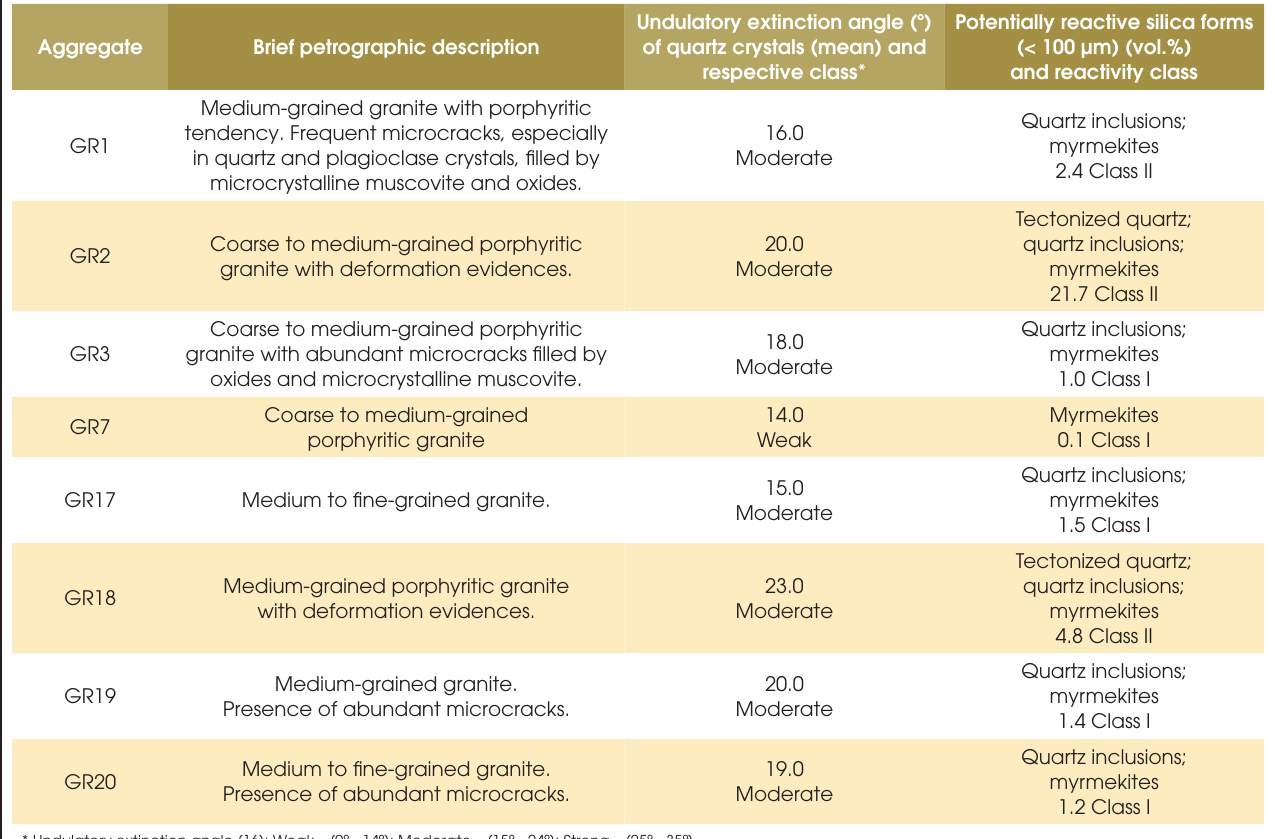
Table 2 – Results of the petrographic characterization of the investigated granitic